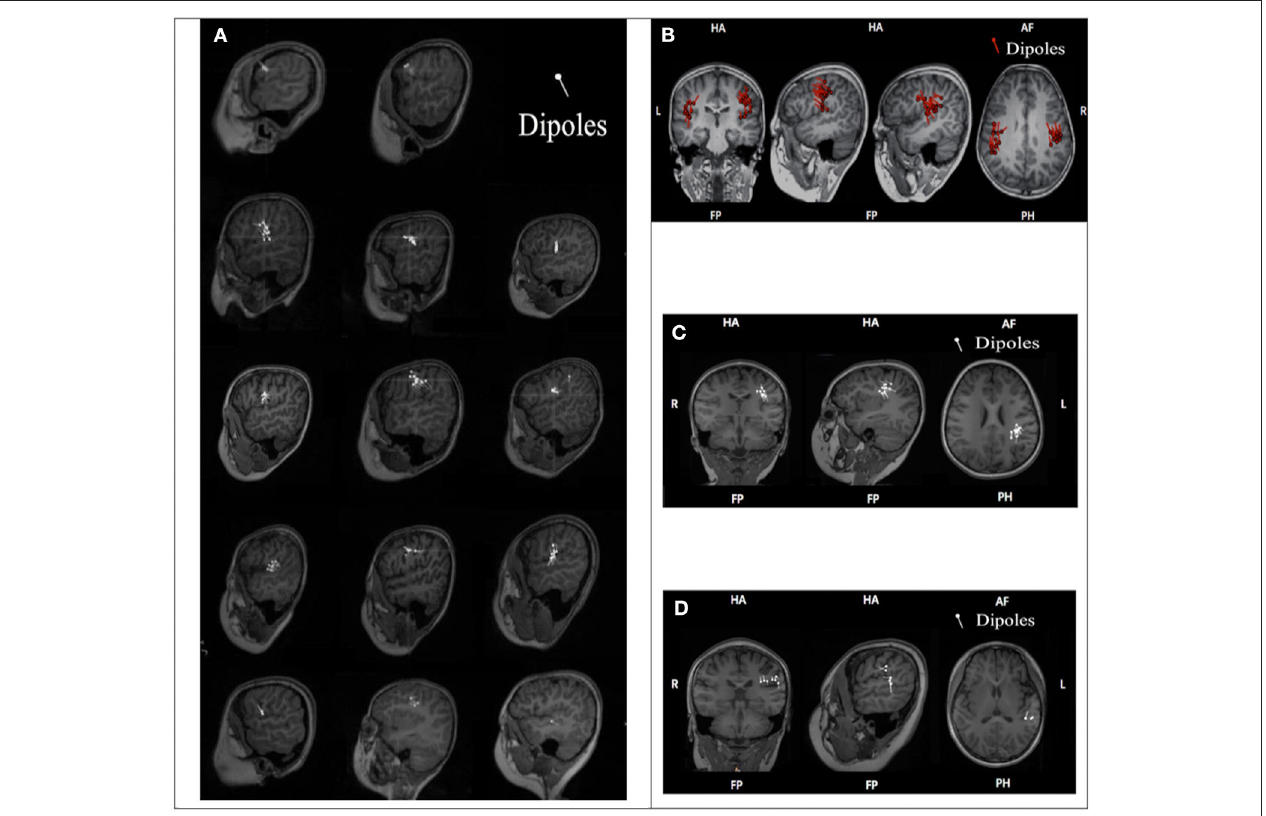
FIGURE 1 | ELP4 rs662702 genotypes and CTS source distributions in 17 patients. (A) Genotype and distribution of CTS sources (dipoles) in 14 BECTS patients. Line 1: Two BECTS patients were ELP4rs662702 CC homozygous and their CTS sources were located in the frontal lobe. Lines 2–4: Nine BECTS patients were ELP4rs662702 CC homozygous and their CTS sources were mainly located in the central region. Line 5: Three BECTS patients were ELP4rs662702 CT homozygous and their CTS sources were located in the frontal gyrus, middle frontal gyrus, and superior temporal gyrus (from left to right). (B) The CSWS patient was ELP4rs662702 CC homozygous and his CTS sources were located in the bilateral inferior pre-central gyrus. (C) The ABPE patient was ELP4rs662702 CC homozygous and his CTS sources were located in the left inferior pre-central gyrus. (D) The ABPE patient was ELP4rs662702 CC homozygous and his CTS sources were located in the inferior post-central gyrus and superior temporal gyrus.